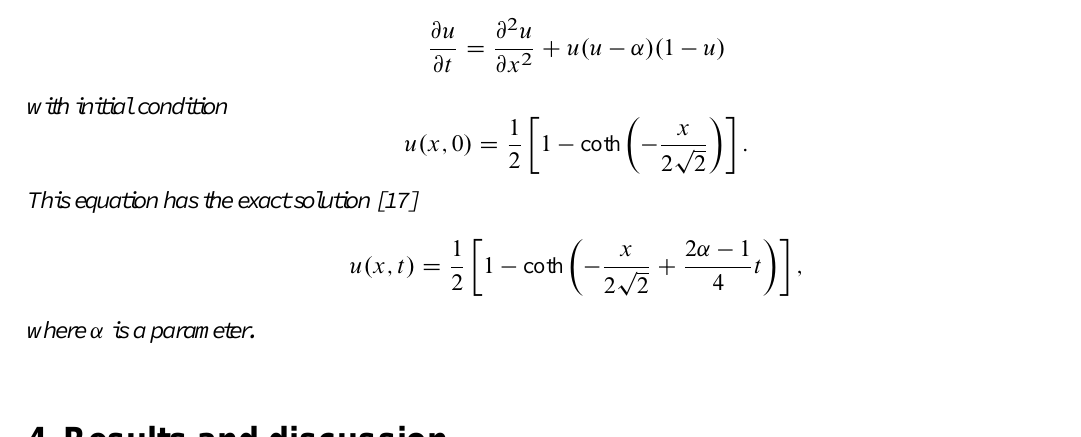
Table 1. Maximum errors E N for Fisher’s equation when ˛ = 1 using N x D 30